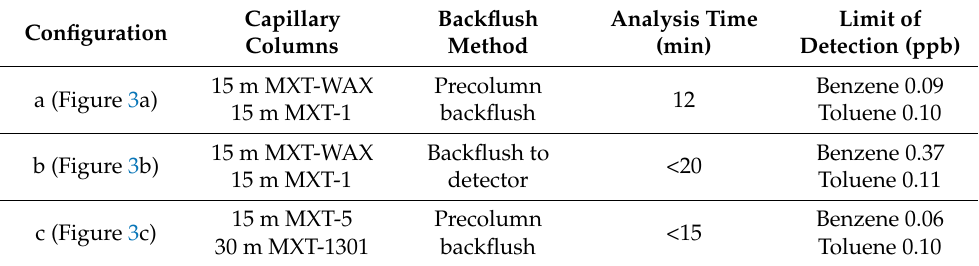
Table 1. BTEX GC-PID descriptions for configuration a, b, and c. Configuration a and b had the same capillary columns with different backflushing method, while configuration c retained the precolumn backflushing method with new capillary columns. Only benzene and toluene limit of detections are show for comparison